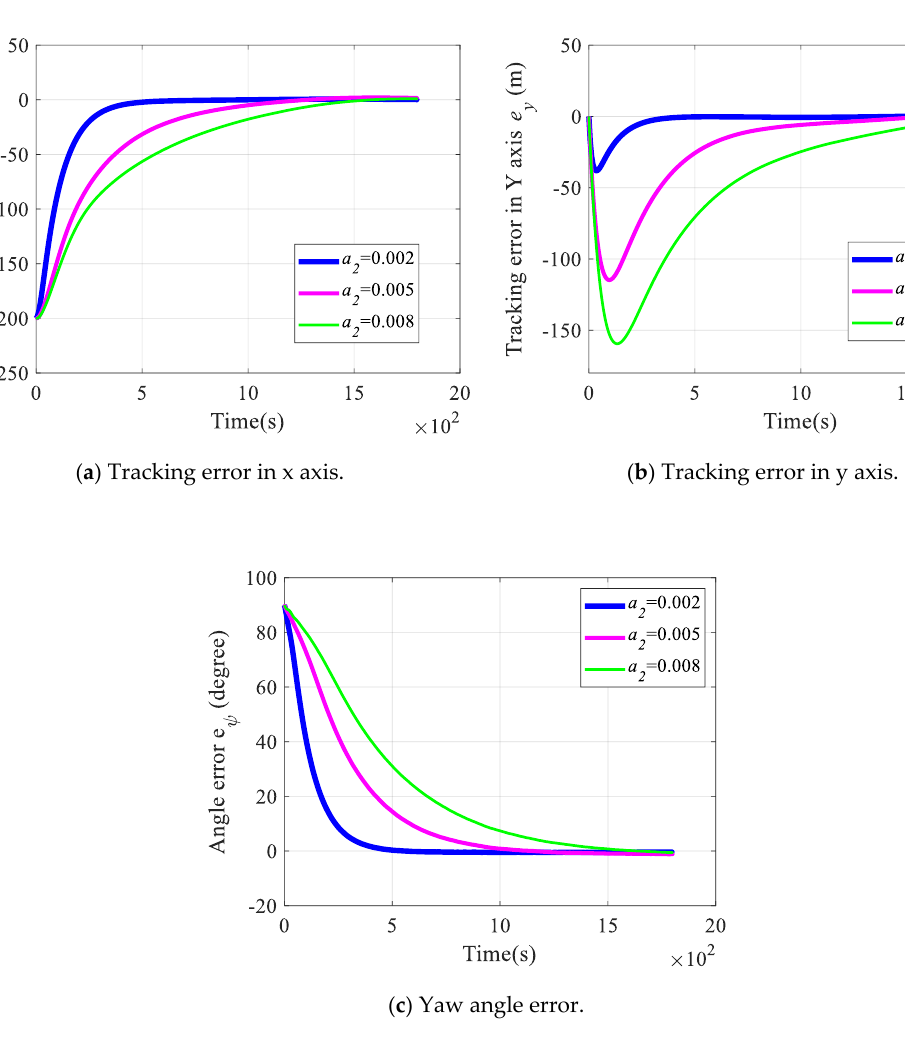
Figure 12. Tracking errors of controlled AUSV with respect to di ff erent control gains a 2